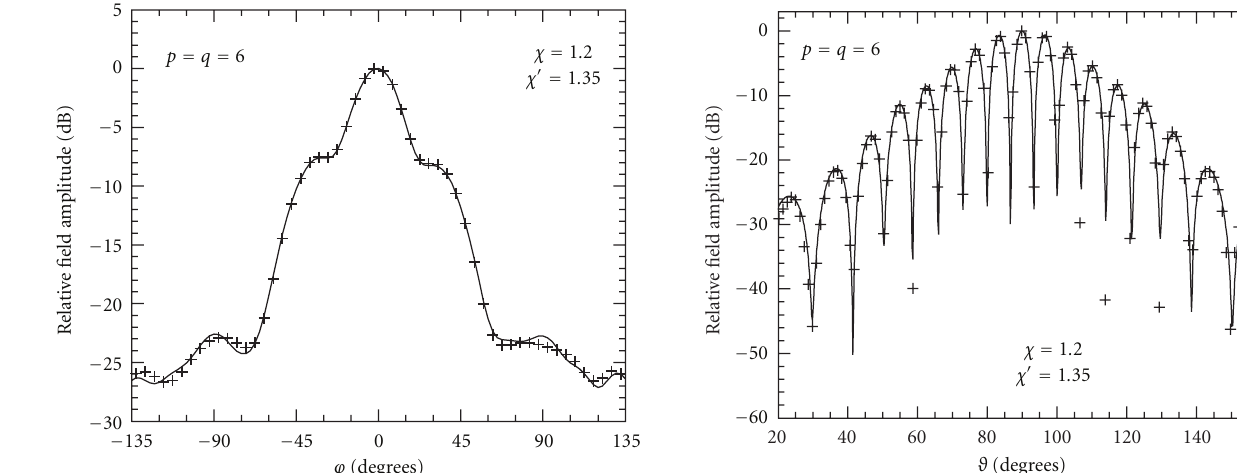
Figure 22: H-plane pattern. Solid line: direct FF measurements. Crosses: reconstructed from NF data acquired via the helicoidal